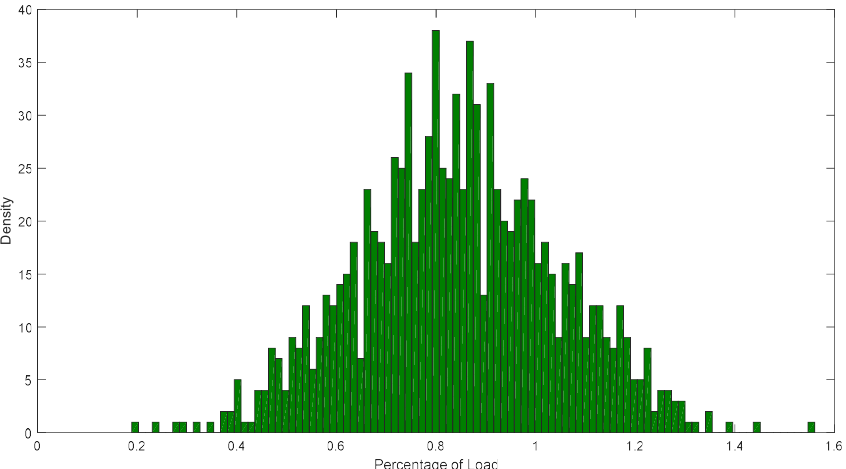
Figure 4. PDF of the demand for each bus of the 33-bus network.